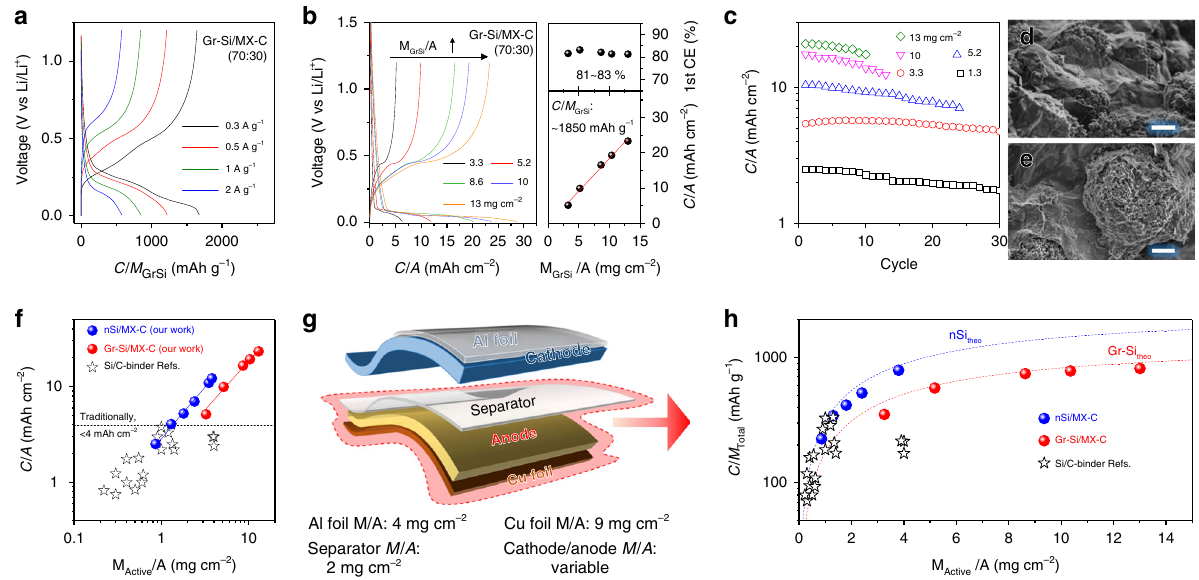
Fig. 5 Electrochemical characterization of Gr-Si/MXene anodes and comparison to literature. a Typical galvanostatic charge-discharge (GCD) curves of Gr- Si/MX-C electrode (MX-C M f = 30 wt%, M GrSi / A = 3.3 mg cm − 2 ) at various current densities. b Left: GCD pro fi les of Gr-Si/MX-C electrodes with various M / A at 0.1 A g − 1 (~1/20 C-rate). Right: fi rst CE (up) and C / A (down) of Gr-Si/MX-C plotted as a function of M A . c Cycling performance of Gr-Si/MX- Gr-Si / C electrodes with various M GrSi / A at 0.2 A g − 1 (~1/10 C-rate). d , e Scanning electron microscopy images of the Gr-Si/MX-C electrode ( M GrSi / A = 3.3 mg cm − 2 ) after cycling, showing that the MX-C binder tightly wrapped the Gr-Si particles and maintained the structural integrity (scale bar for d and e = 2 µ m). f Areal capacity comparison of this work to other Si/conductive-binder (Si/C-binder) systems, showing that our Si/MX-C electrodes have